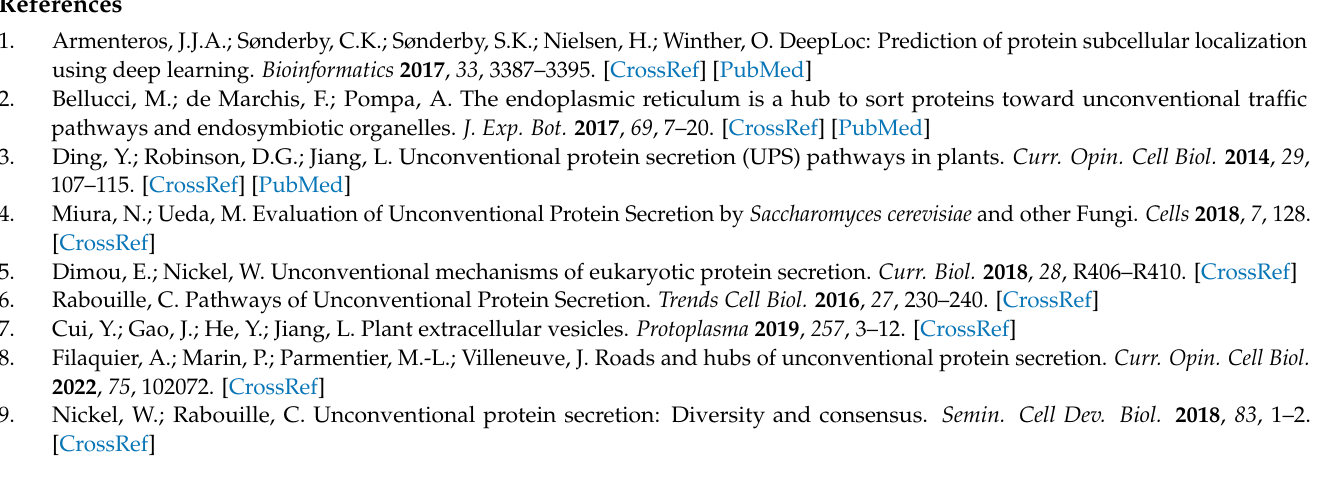
LSPDB, Table S2: Updated Sol LSP results, Supplementary Methods—LSPDB, Figure S1: SPLpred design, Figure S2: SPLpred comparisons, Figure S3: LSPpred comparisons, Figure S4: Model feature importance, Figure S5: Other tools and data. References [45–69] are cited in the Supplementary